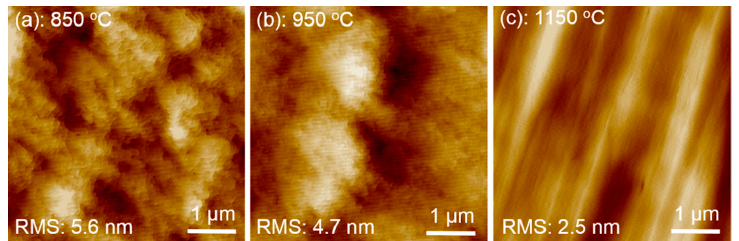
Figure 5. AFM images of N-polar GaN epilayers with AlN buffer layers grown at temperature of ( a ) 850 °C; ( b ) 950 °C; and ( c ) 1150 °C, respectively, with a scanning area of 5 × 5 μ m 2 .